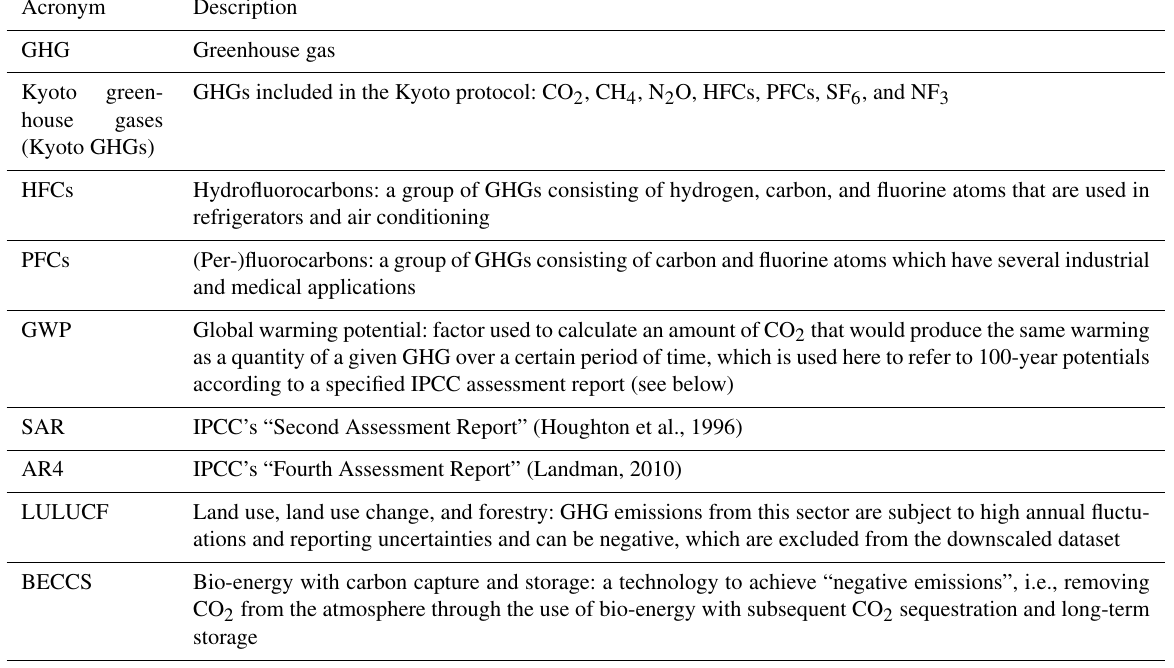
Table A1. Greenhouse-gas-related